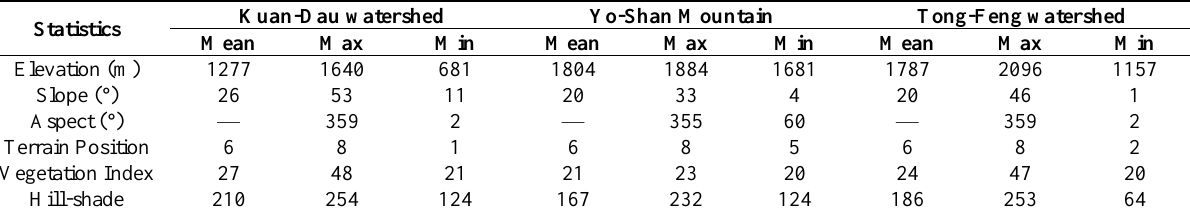
Table 2. The statistics of environmental variables for CGTs in the two